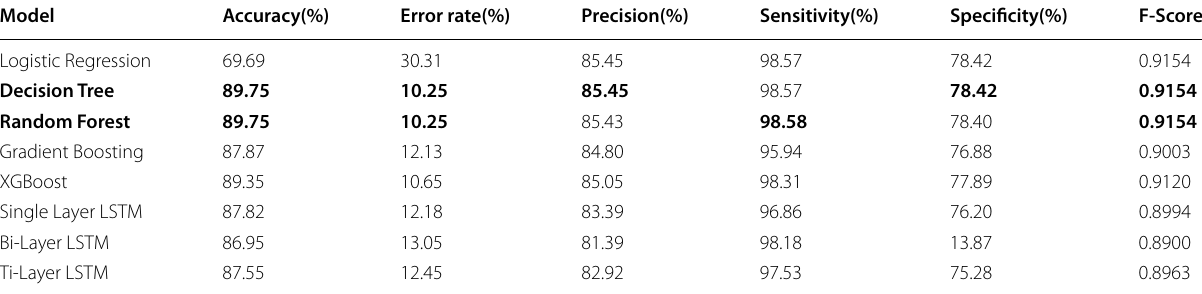
Table 7 This table presents the performance results of each predictive model for the task level based on the test dataset, where the models in bold represent the best models